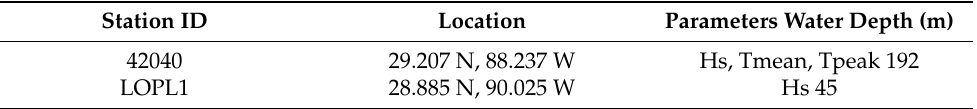
Table 1. NDBC wave buoy 42040 and LOPL1 information and wave parameters used for model evaluation.